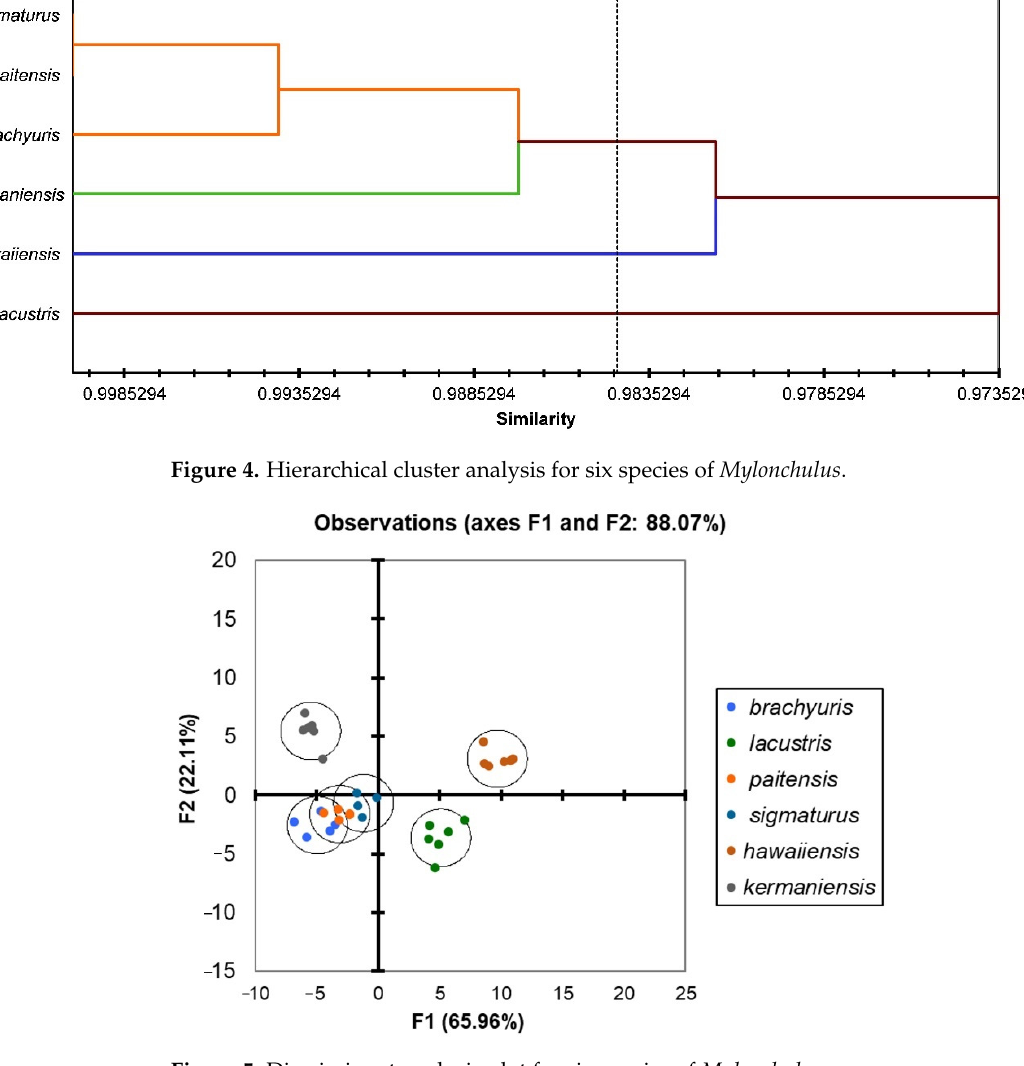
Figure 5. Discriminant analysis plot for six species of Mylonchulus .